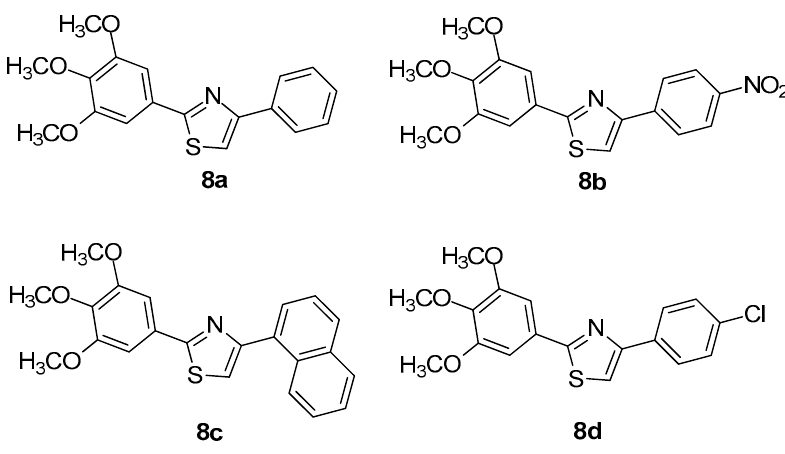
Figure 9. Chemical structures of compounds 8a – d .